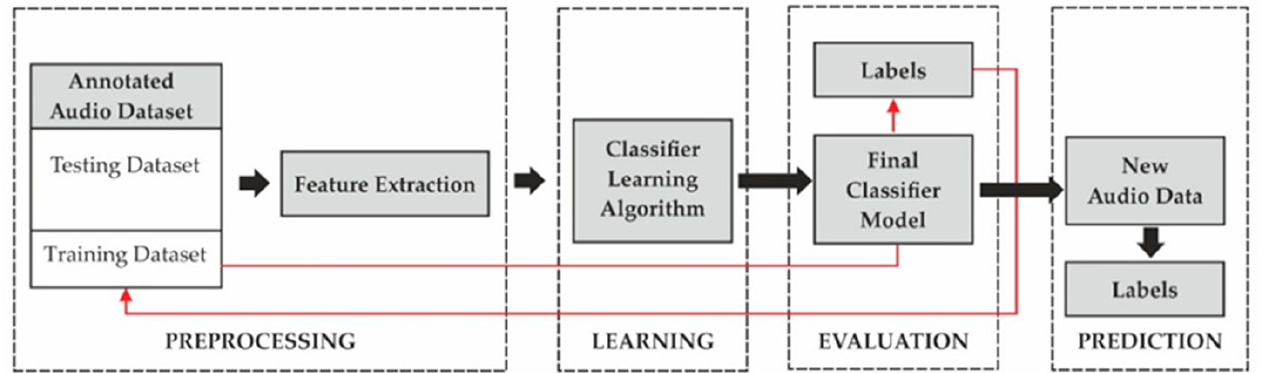
Figure 2. Schematic of feature extraction-based technique for machine fault detection based on acoustic inputs.